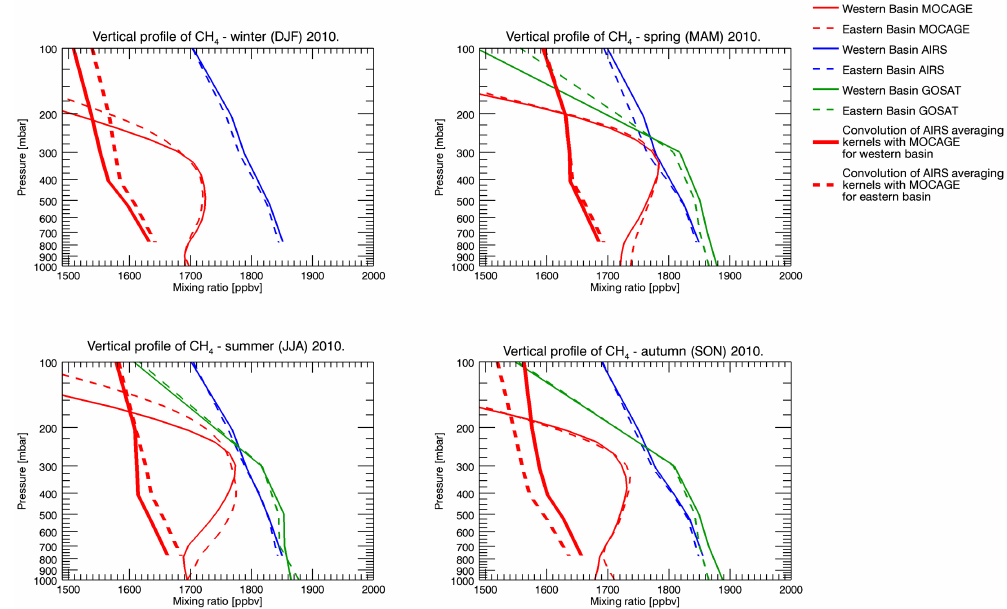
Figure 6. From top to bottom and from left to right: seasonally averaged vertical profiles of CH 4 as measured by AIRS (blue lines) and GOSAT (green lines), and as calculated by MOCAGE (thin red lines) over the Eastern (dashed lines) and Western (solid lines) MBs in winter, summer, spring and autumn 2010. Also shown are the seasonally averaged MOCAGE profiles convolved with the AIRS averaging kernels (thick red lines) for the four seasons over the EMB (dashed lines) and WMB (solid